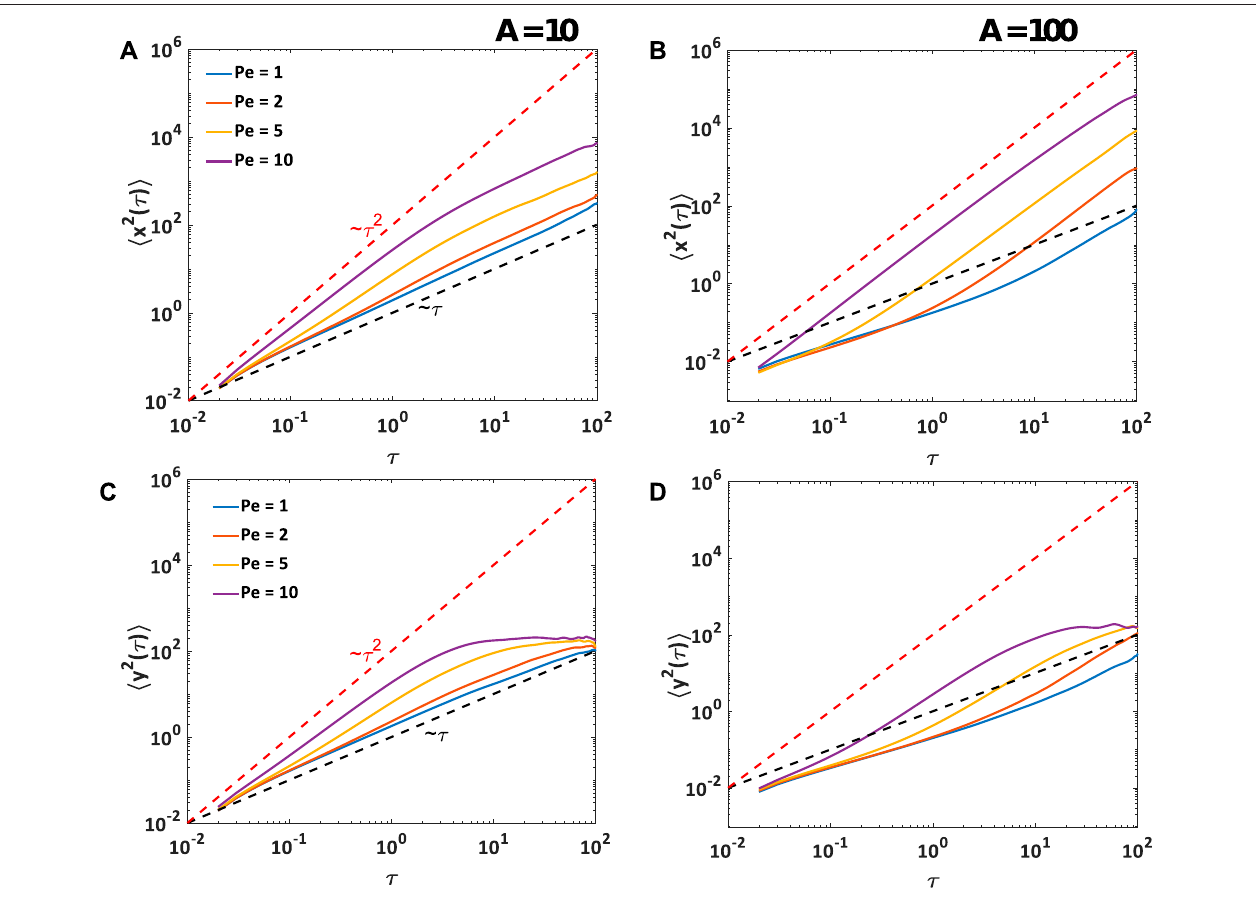
FIGURE 7 | Mean-Squared Displacement, or MSD, vs . time interval, for 100 particles in a square simulation box of 30 σ . Due to con fi nement of particles in y -direction, MSD isplotted separatelyfor x and y components ofdisplacement. (A) , (B) MSD alonguncon fi ned direction: for A = 10,particlesaresuper-diffusive at short time scale and diffusive at longer time scale, where the crossover time scale is determined by the Péclet number ( Pe ) of the particles. At A = 100, particles align themselves to form chains or clusters. At low Pe , the particles show sub-diffusive behavior at shorter times and ballistic behavior at longer times. At higher Pe , the ballistic behavior of particles is observed at all time scales. (C) , (D) MSD along con fi ned direction: particles reach the con fi ning boundary at shorter times for high Pe number, and also at low elastic interactions A . At higher A , particles chain up and move predominantly parallel to the con fi ning